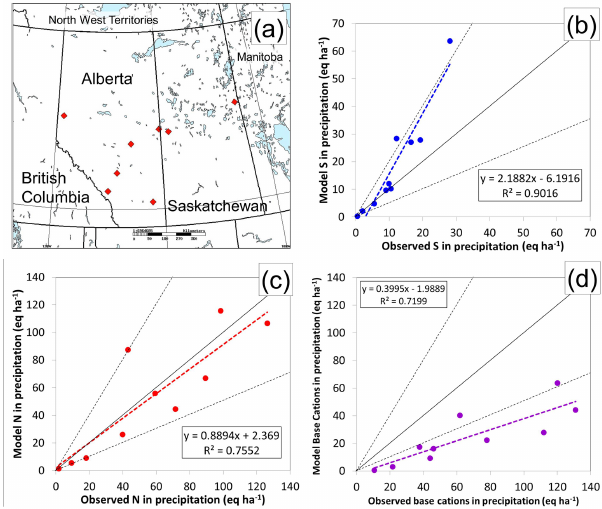
Figure 8. (a) Ions-in-total-precipitation sample collection sites. Scatterplots compare model and observed wet deposited (a) S, (b) N, and (c) base cations in precipitation (eqha − 1